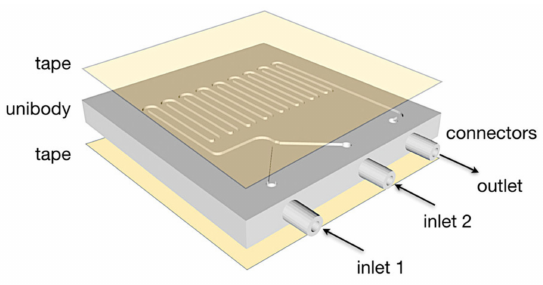
Figure 2. Transparent double-sided tape was applied to the top and bottom of the